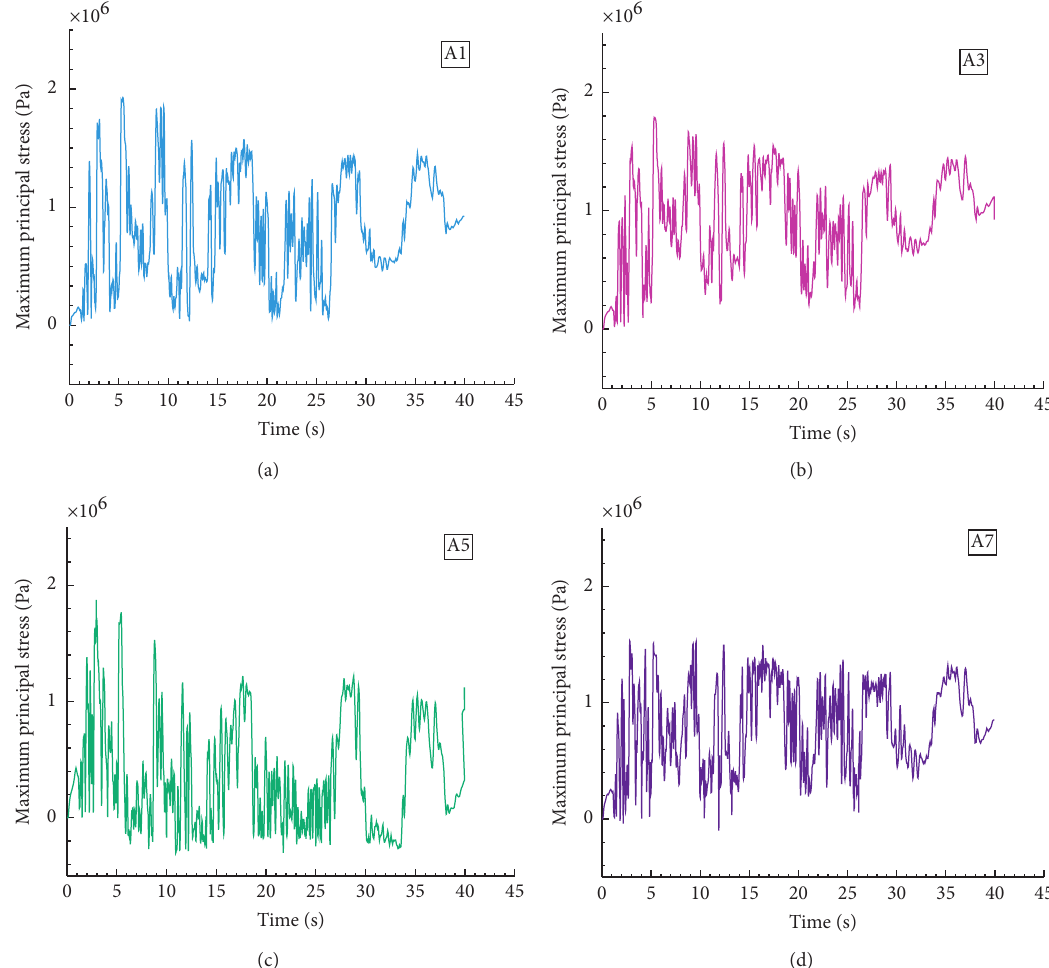
Figure 16: Time history of maximum principal stress